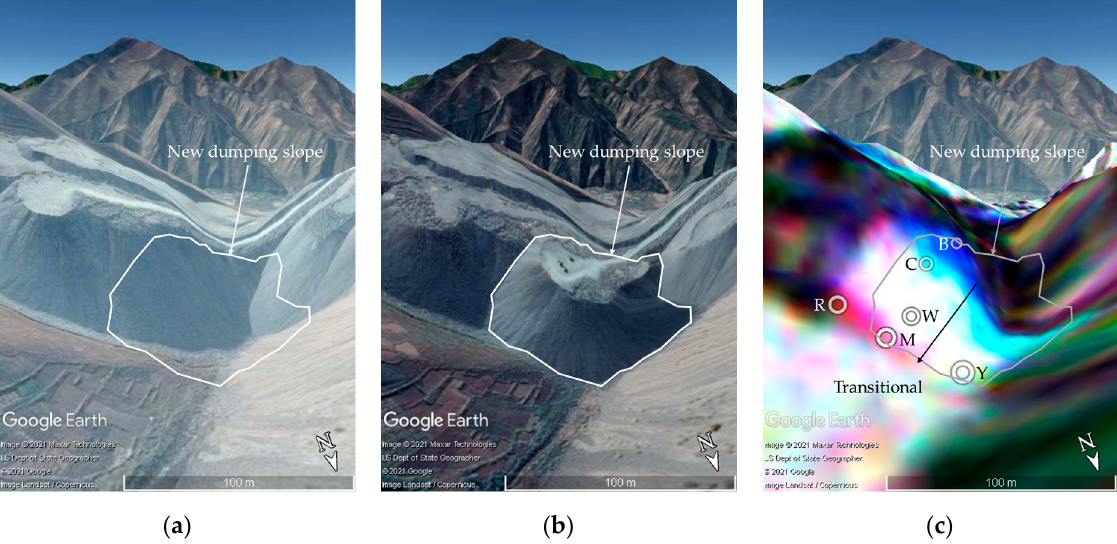
Figure 19. East Dumping Site 1 (ED1). ( a , b ) are Google Earth images taken on 7 October 2015 and 26 September 2019, respectively. ( c ) is the RGB composite of the annually averaged NDAI map (R: 2019, G: 2018, and B: 2017) with several color points where 12-day NDAI graphs are shown in Figure 20. Solid lines are drawn based on the 2019 Google Earth image.